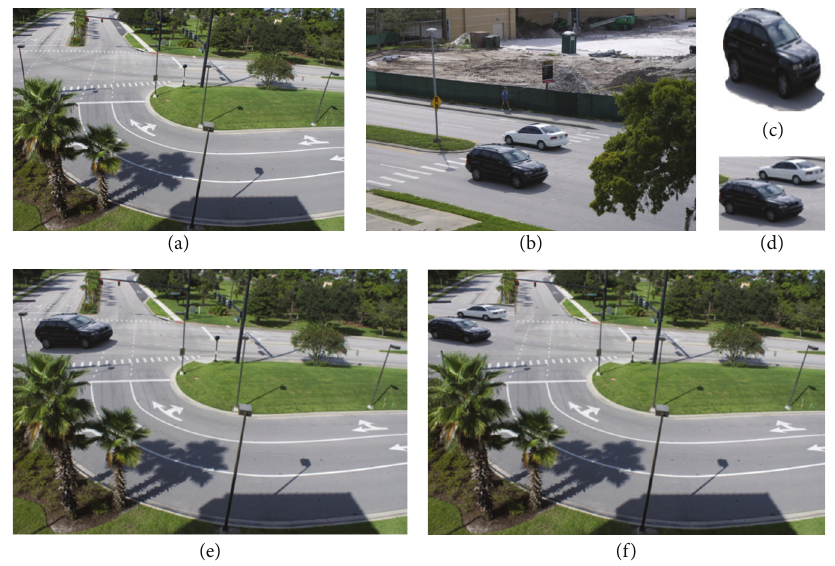
Figure 1: The samples of image forgery with